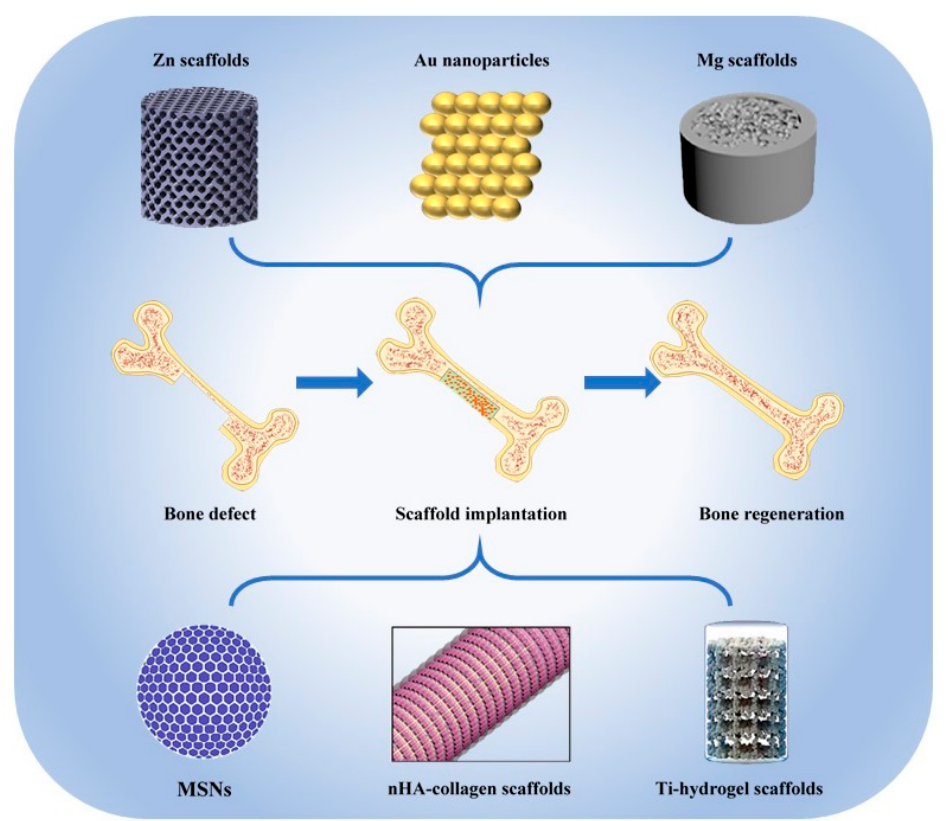
Figure 1. The main inorganic nanomaterials used for bone tissue regeneration [10–14].